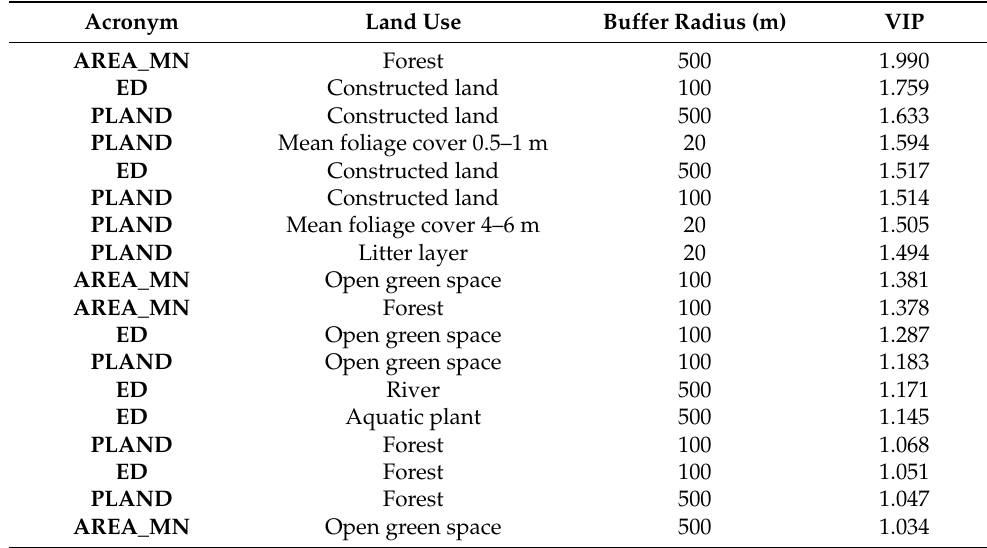
Table A4. The PLSR analysis utilizes bird FDis as the response variable and landscape- and patch- level variables as the explanatory variables. The explanatory variables with VIP ≥ 1 were selected (sorted by VIP score